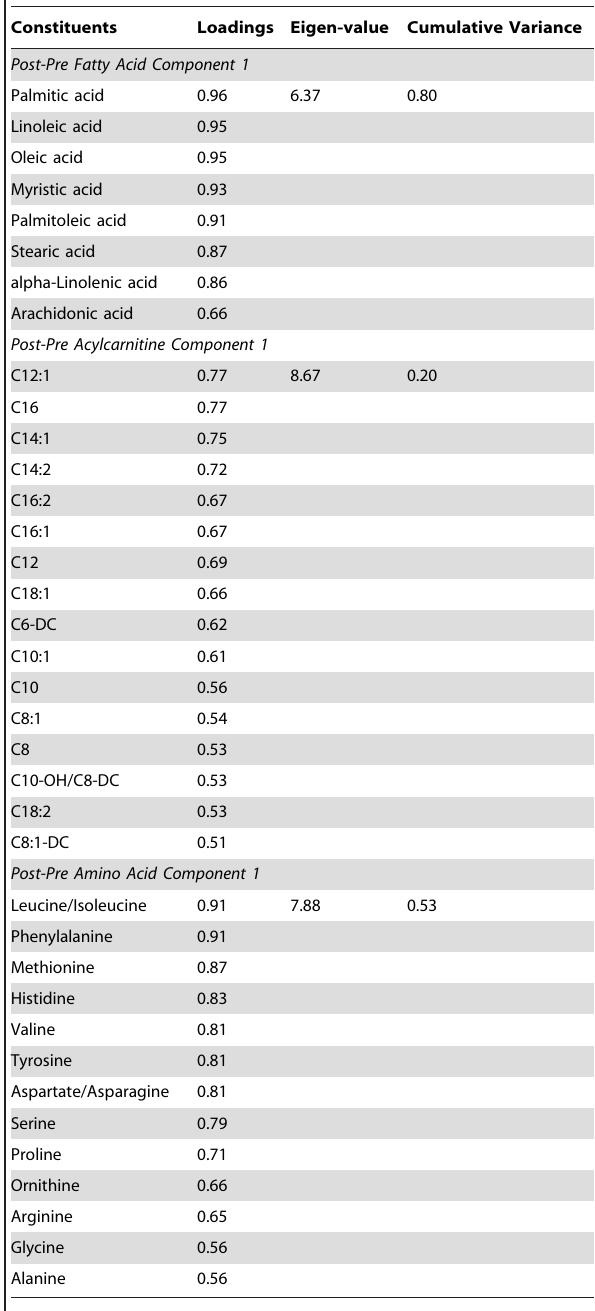
Table 1. Principal Components Analyses (PCA) for Fasting to Postprandial Changes in